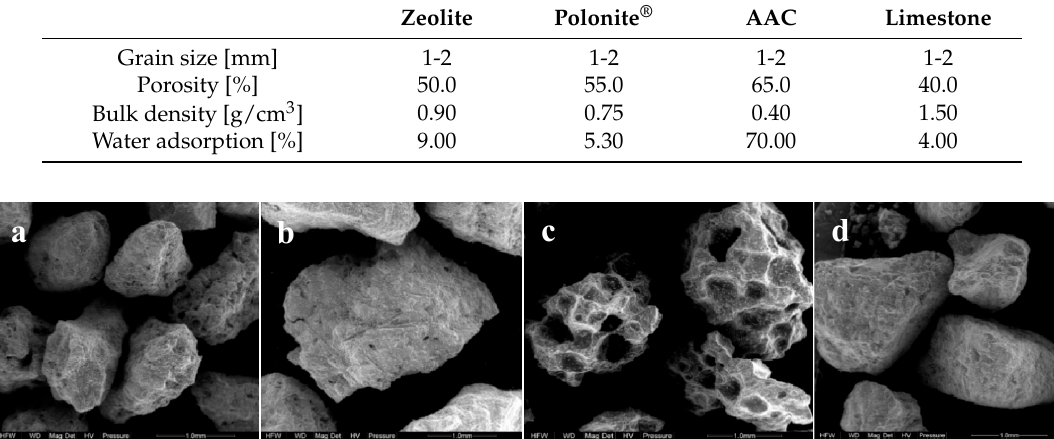
Table 3. Physical properties of tested reactive materials. Figure 1. Scanning electron microscope (SEM) micrographs of ( a ) zeolite; ( b ) Polonite ® , ( c ) AAC, ( d ) Limestone.